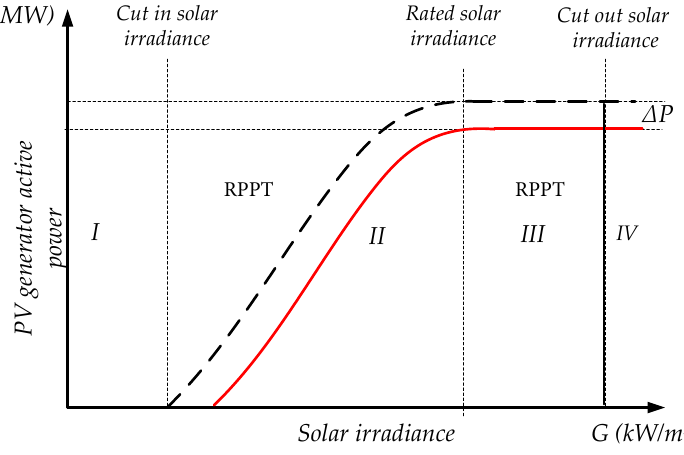
Figure 12. Control areas of a PV generator in a P-G curve when power reserve is considered.